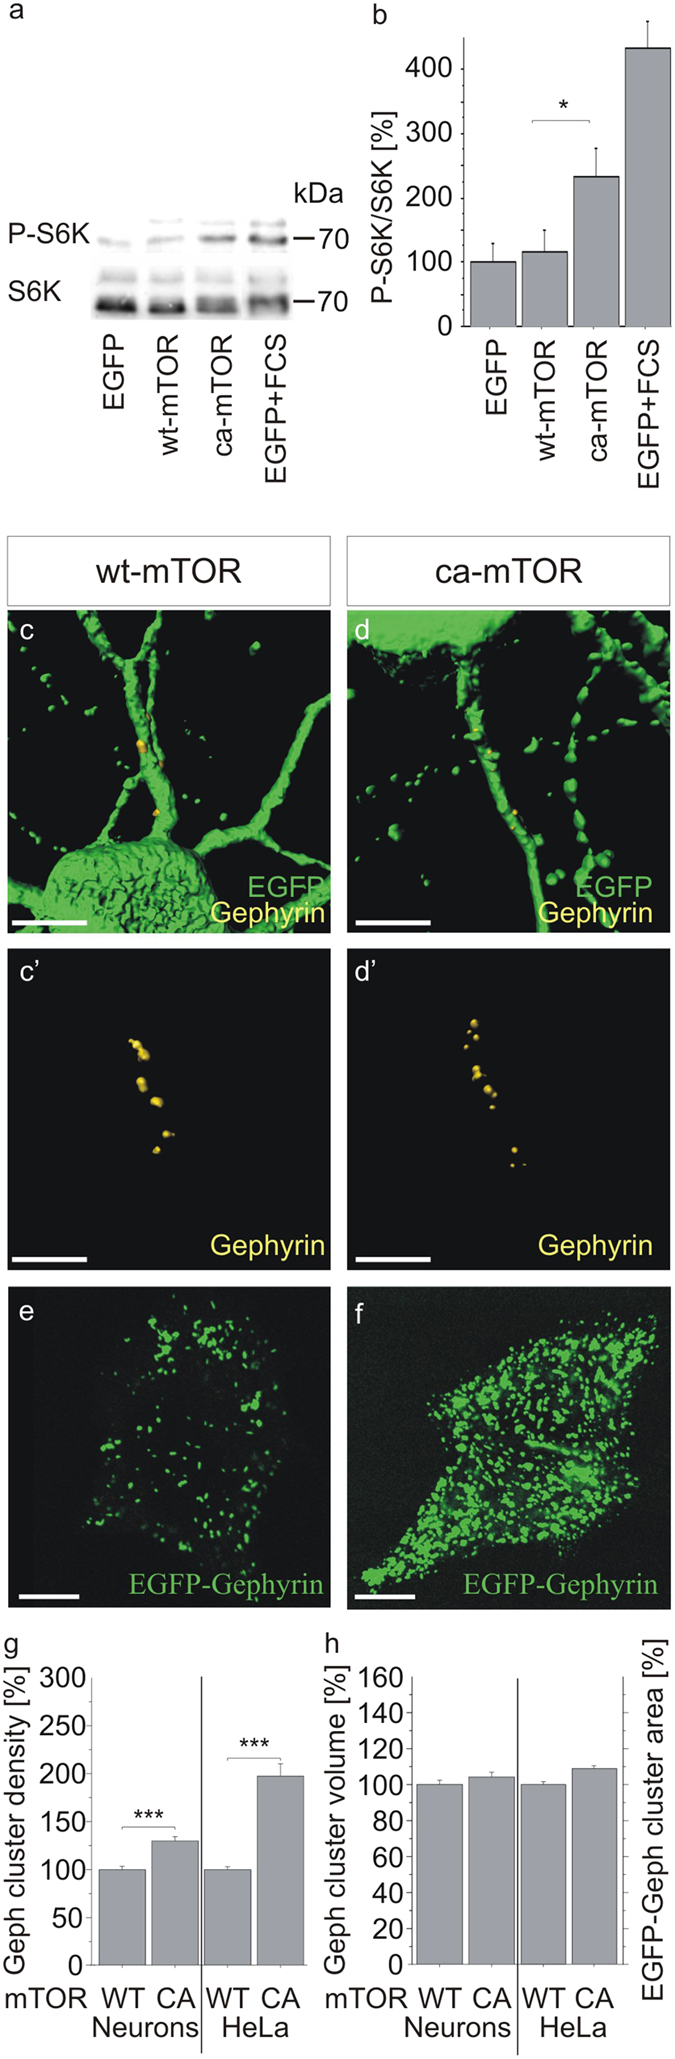
mTOR activation increases gephyrin clustering.(a,b) ca-mTOR induces S6K phosphorylation. Lysates of HeLa cells transfected with plasmid vectors expressing EGFP, wt-mTOR, or ca-mTOR were analyzed by Western blotting to quantify total S6K protein (70 kDa isoform) or phosphor-S6K. Stimulation with fetal calf serum (FCS) served as a control. S6K proteins were detected by a pan-S6K antibody (S6K) or a phospho-S6K antibody (pS6K; pThr389), respectively (upper bands correspond to the 85 kDa isoform of S6K). (b) Densitometric analysis of signals obtained after western blotting as exemplified in (a). Bar charts represent ratios of pS6K to pan-S6K signals as percentage of the EGFP-transfected control. n = 6; *p < 0.05. ANOVA, Fisher-PLSD; error bars, S.E.M. (c) ca-mTOR increases gephyrin cluster densities. Either hippocampal neurons (c,d); gephyrin staining in c,d is shown in c’,d’) or HeLa cells (e,f) were transfected with plasmid vectors for wild type mTOR (WT) or ca-mTOR (CA). Neurons were cotransfected with pEGFP-N1 for the identification of mTOR transfected cells whereas HeLa cells were additionally cotransfected with EGFP-gephyrin and collybistin expression plasmids to allow for surface translocation of expressed EGFP-gephyrin. Cluster densities of immunocytochemically labeled endogenous gephyrin on dendritic segments of EGFP-positive neurons (n = 40) or of EGFP-gephyrin (n = 13) on the surface of HeLa cells were determined. Values are indicated as percentage of wt-mTOR transfected cells. ***p < 0.0001; Kruskal-Wallis-Test, followed by Dwass-Steel-Test; error bars, S.E.M. (d) Gephyrin cluster size was determined in primary neurons (cluster volumes) or in HeLa cells (surface cluster areas) after transfection of expression vectors for wt-mTOR or ca-mTOR. n > 13; ***p < 0.0001. ANOVA, Fisher-PLSD; error bars, S.E.M. scale bars 30 μm.